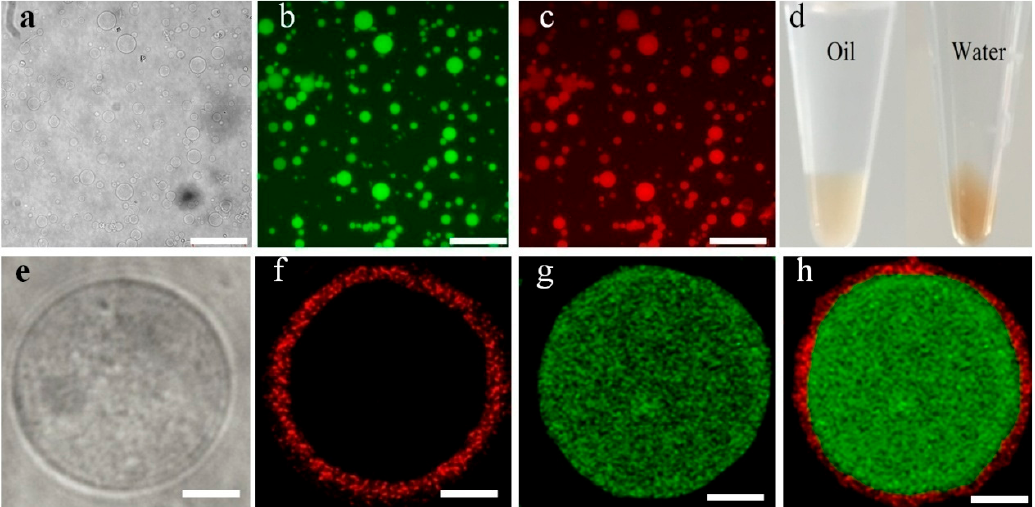
Figure 3. Optical microscope image of original HPs in water phase ( a ), fluorescence microscope images of HPs in water/oil solution, showing green ( b ) and red fluorescence ( c ) derived from encapsulating fluoresce in isothiocyanate labeled dextran (FITC-Dextran MW 500 kDa) and Au NCs, respectively, and the HPs in oil and aqueous phase ( d ). ( e ) Confocal microscopy images showing an HP incorporating Au NCs (red, f ), FITC-dextran (MW 500 kDa, green, ( g ) and the overlapping image ( h ) of ( f , g ) in the shell and core of the HP. Scale bars in ( a – c ) are 100 µm, ( a – d ) are 5 µm, respectively.